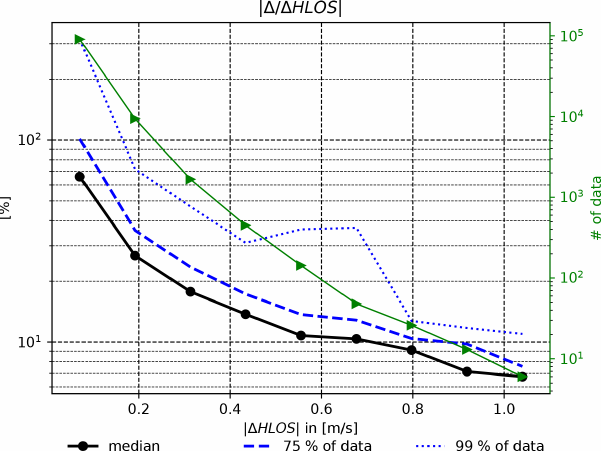
Figure 9. The relative contribution to the HLOS total correction of the HLOS sensitivity to the scattering ratio ( (cid:49) ) compared to the contribution of the HLOS sensitivity to temperature and pressure ( (cid:49) HLOS). A complete description is given in Sect. 4.4. For each value on the x axis (bin spacing of 0.12ms − 1 ) statistics (median, 75th and 99th percentile) are presented together with the amount of data available (green solid